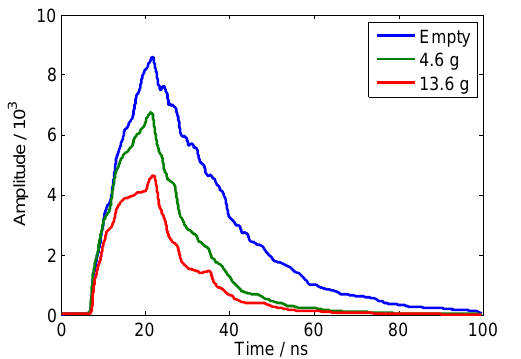
Figure 9. Smoothed envelopes of the time-domain responses from Fig. 4.